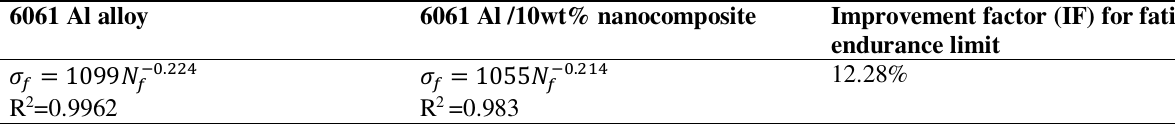
Basquin equations with correlation factor for metal and composite. 6061 Al alloy 6061 Al /10wt% nanocomposite Improvement factor (IF) for fatigue